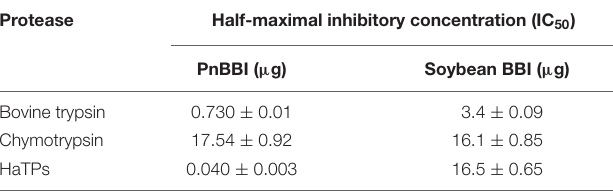
TABLE 2 | Comparison of inhibitory potential of PnBBI and soybean BBI toward Bovine trypsin, chymotrypsin and trypsin-like midgut proteases of H. armigera